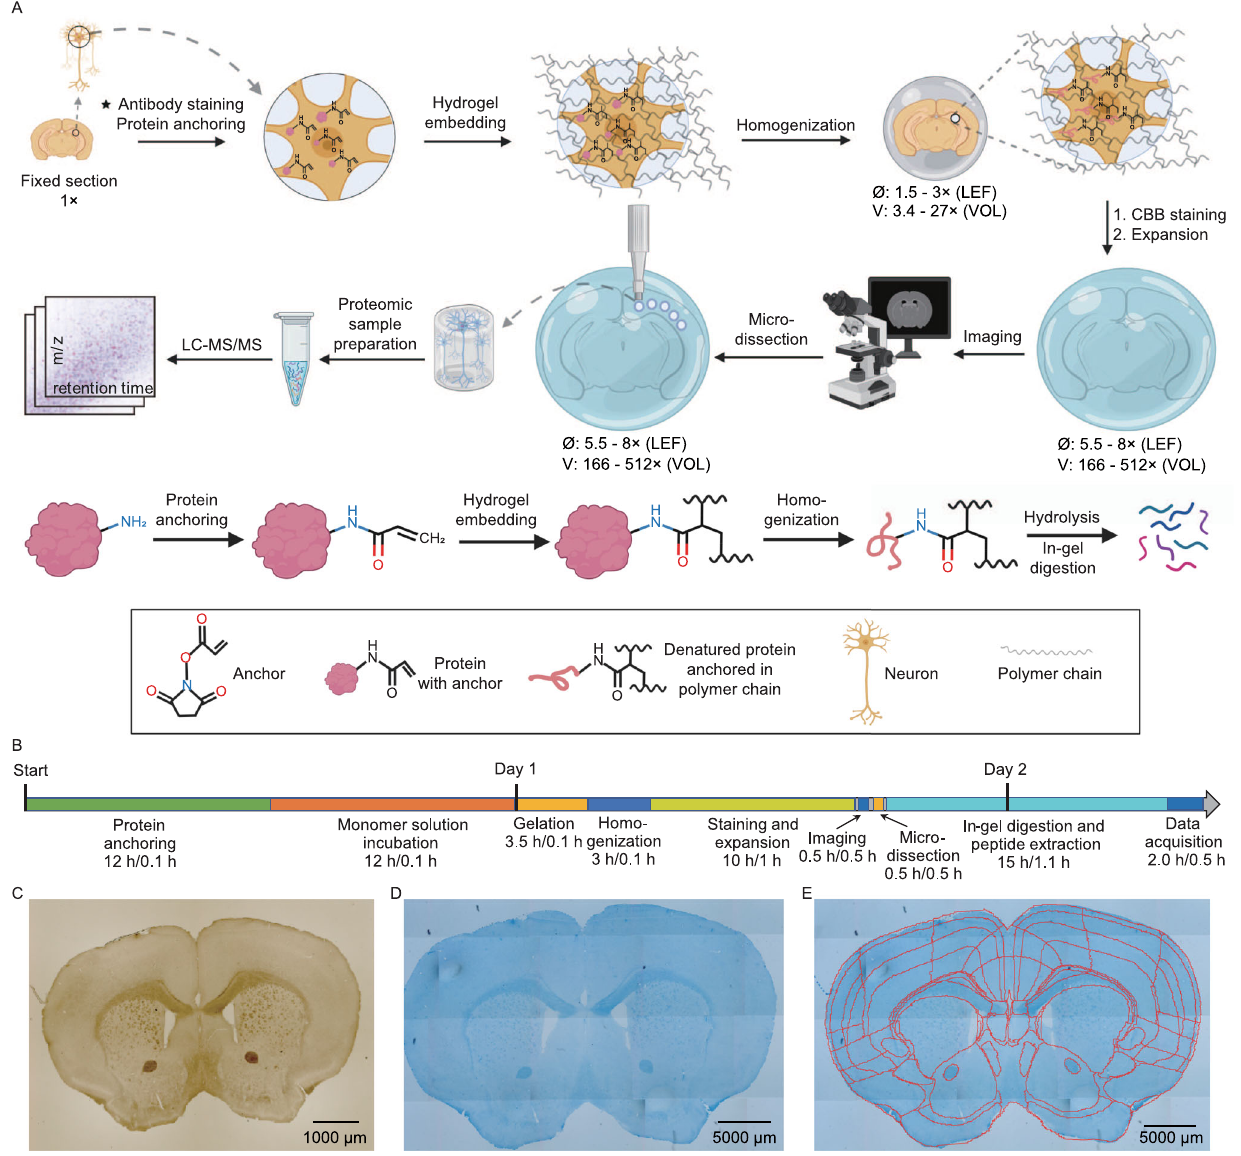
Fig. 1 | ProteomEx work fl ow. A Chemically fi xed tissue samples, which can be immunostained beforehand, are treated with the chemical anchor, embedded into the hydrogel, and mechanically homogenized by mild denaturation. The Coomassie brilliant blue (CBB) hydrogel embedded samples are expanded and imaged.Afterimaging,expandedsamplesaremicrodissectedandexcisedpiecesof the tissue-hydrogel composite are processed by in-gel digestion to recover